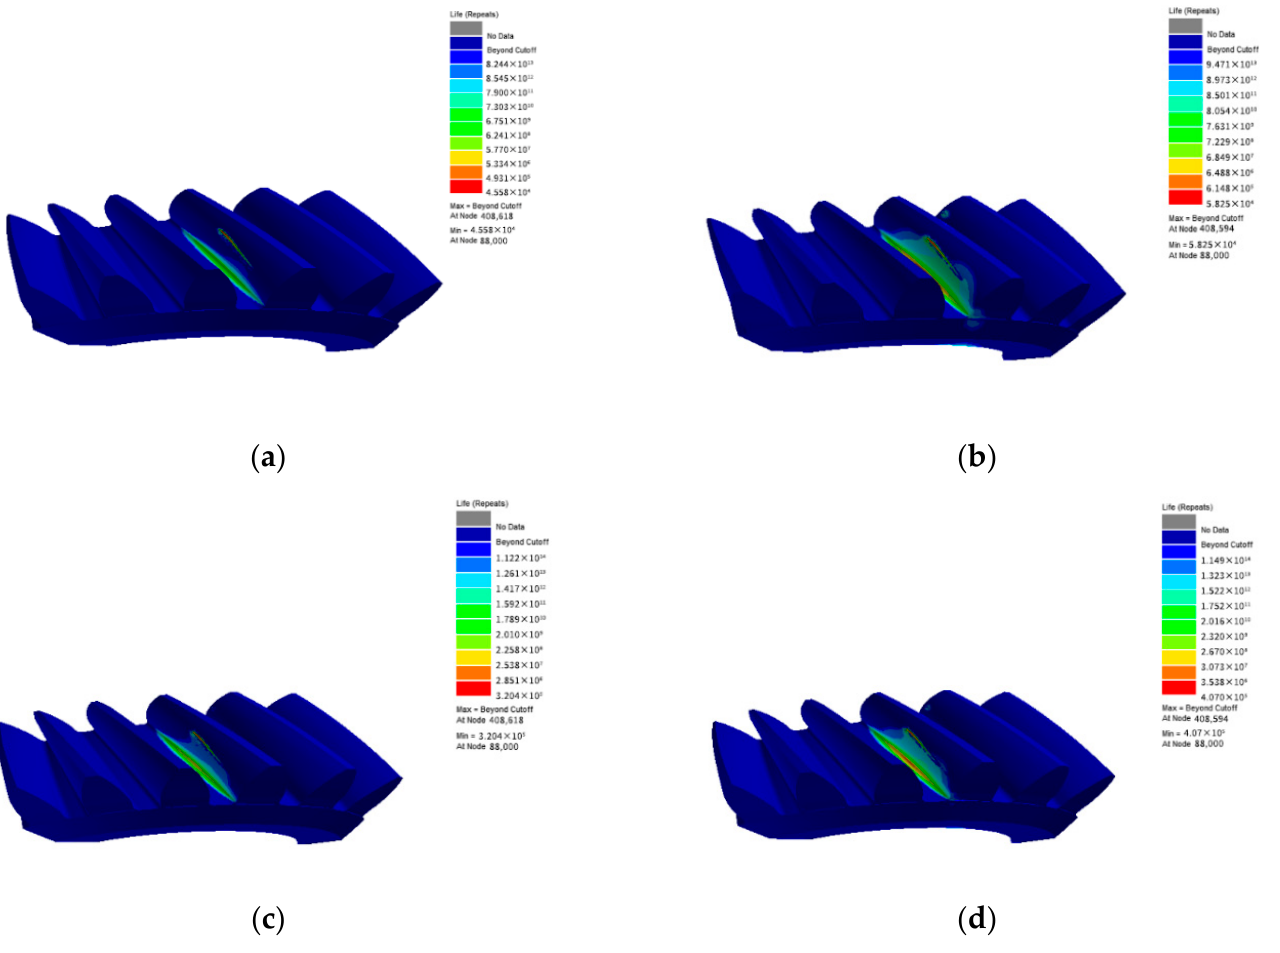
Figure 16. Fatigue life maps of pinion with four load spectrums. ( a ) With contact stress load spectrum of electro-magnetic braking; ( b ) With contact stress load spectrum of friction braking; ( c ) With bending stress load spectrum of electro-magnetic braking; ( d ) With bending stress load spectrum of friction